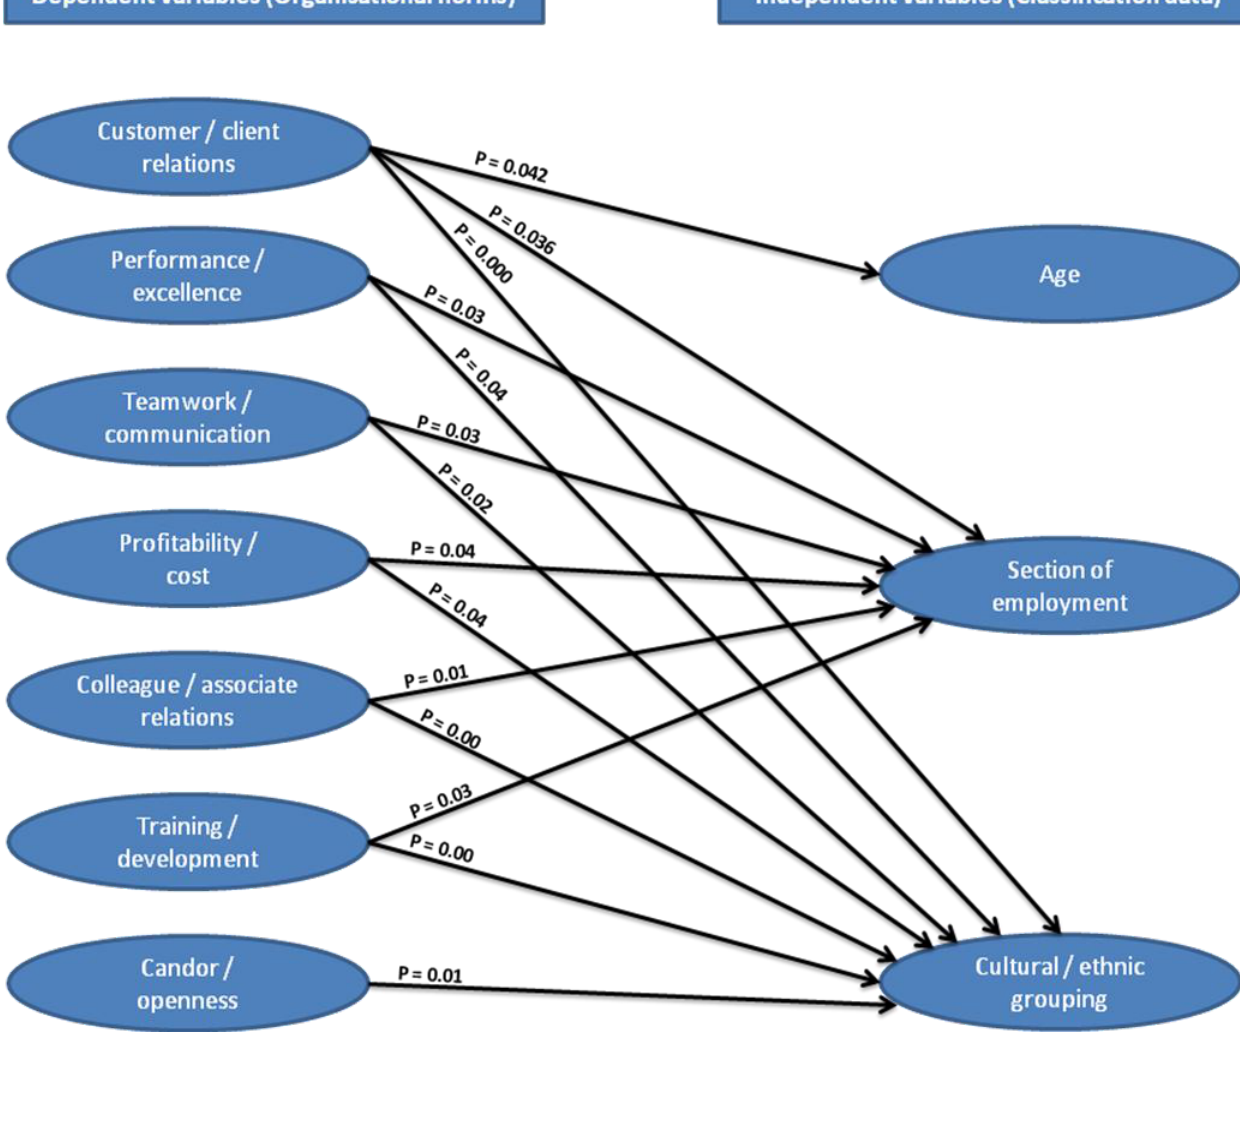
Figure 1: Relationships between the independent and dependent variables and testing of